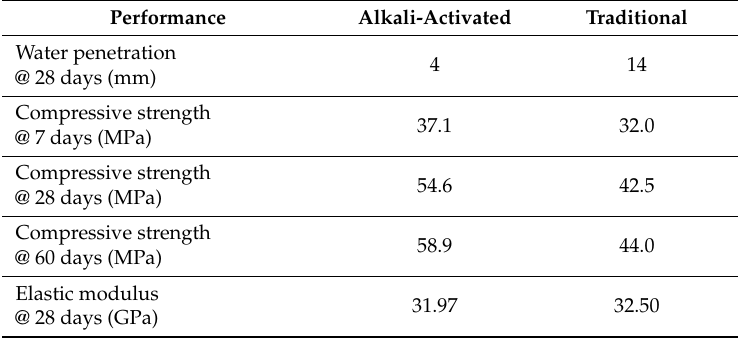
Table 4. Performance comparison of alkali-activated and traditional